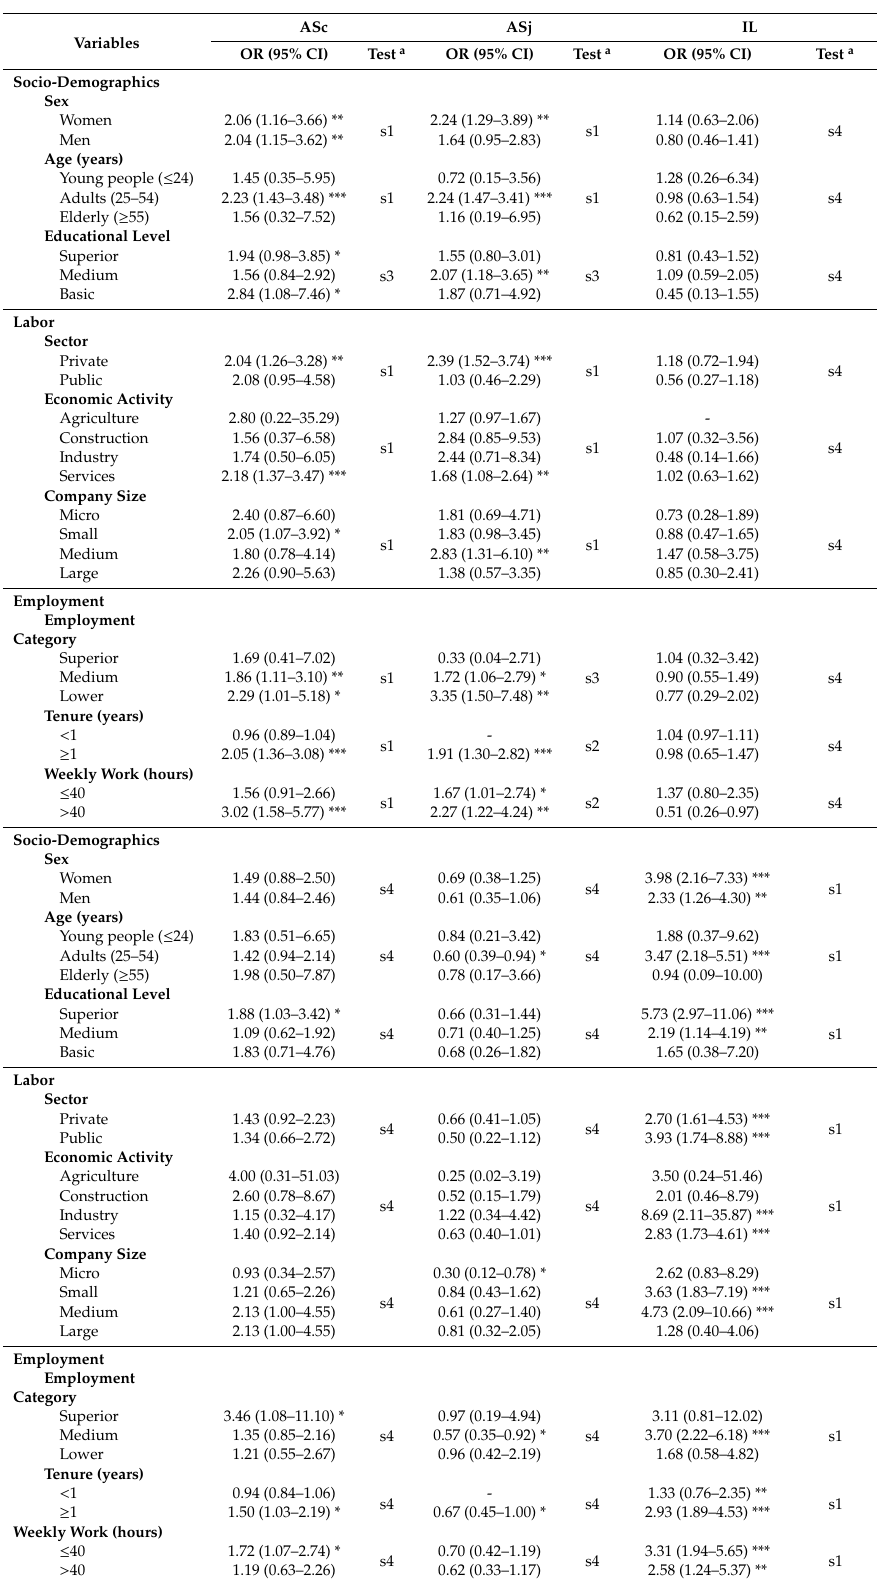
Table 2. Stratified odds ratios of psychosocial risk factors at work and poor